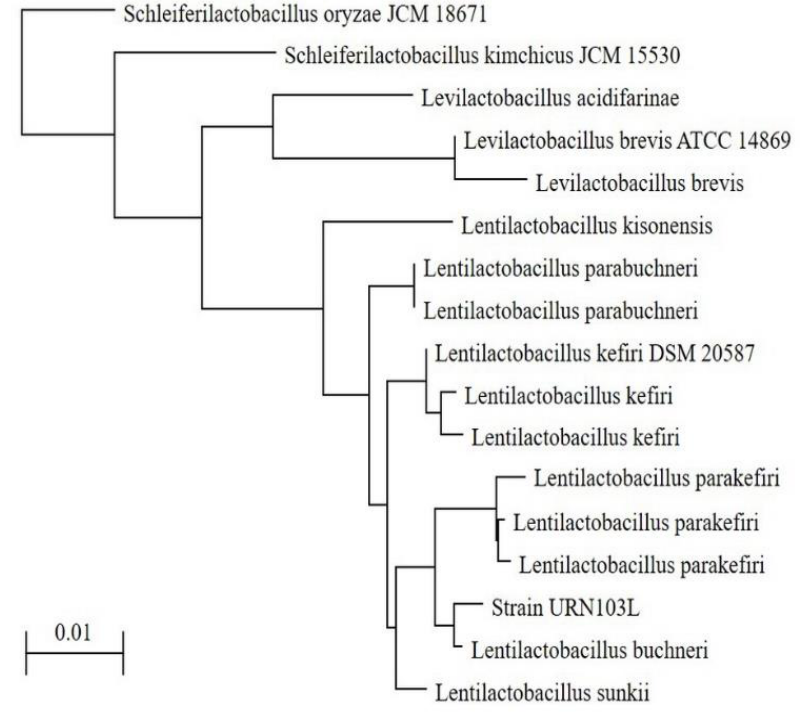
Figure 3. Phylogenetic tree based on 16S rDNA sequences. Phylogenetic relationships of strain URN103L with other Lentilactobacillus sp. are shown. Bar (0.01) is scale length.